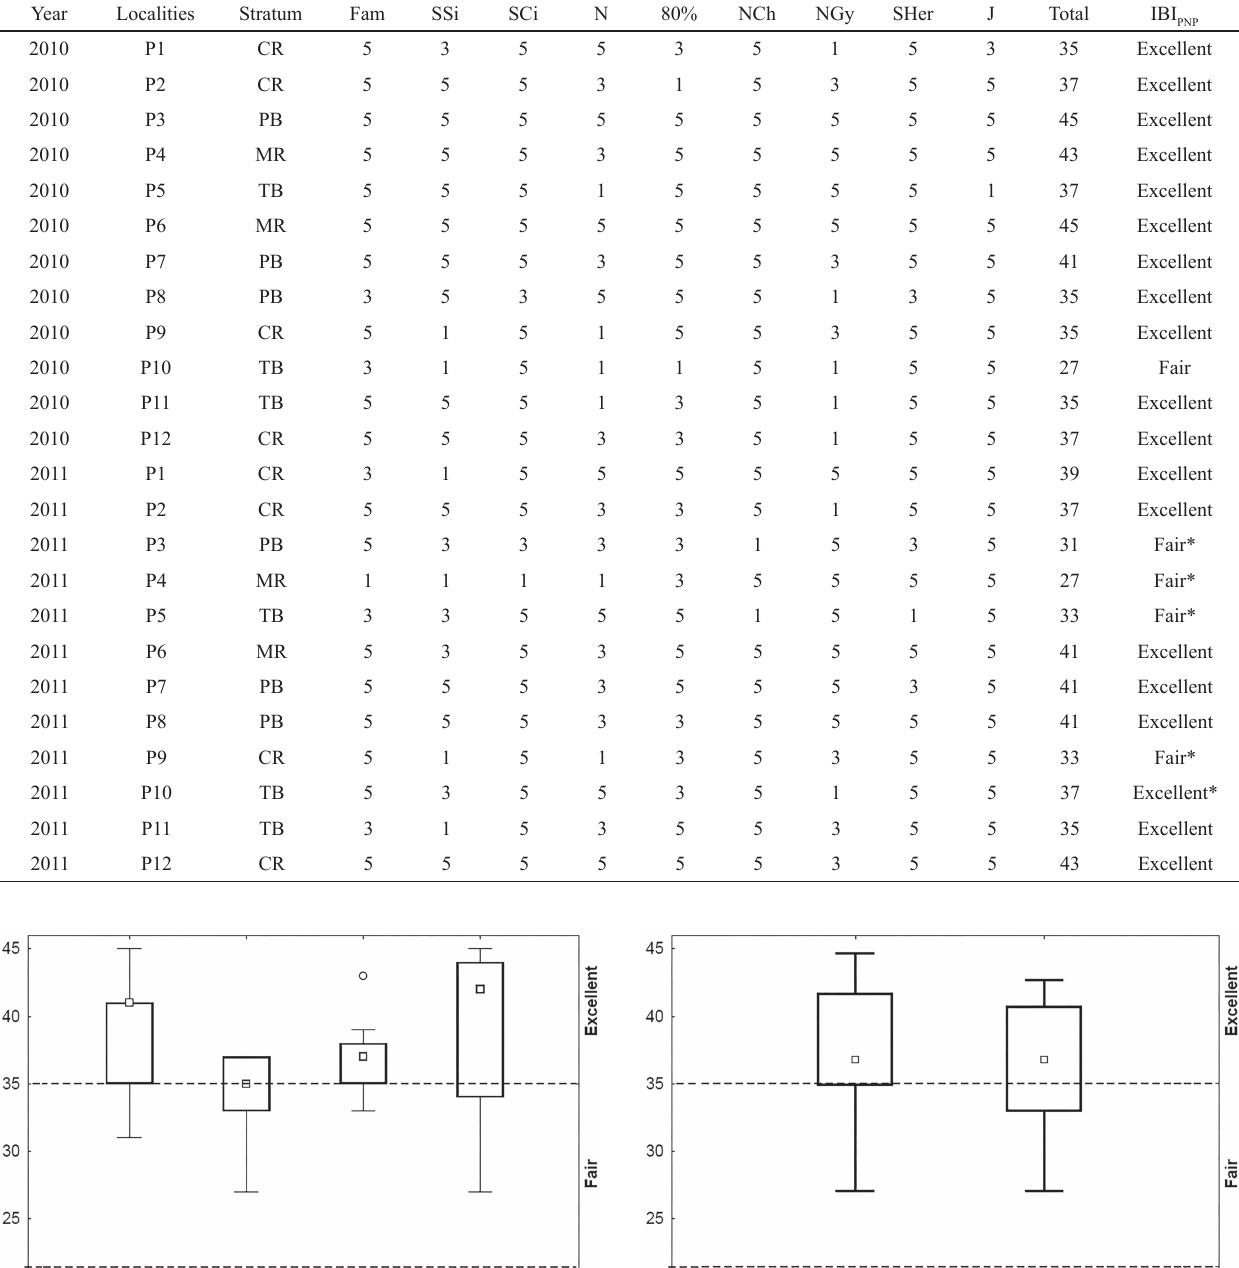
Tab. 4. Scores of selected metrics for IBI in 24 sampling points in the Pantanal National Park during the dry period PNP (Oct-Nov) of 2010 and 2011. (*) Metrics that had different classes of integrity in 2010 and